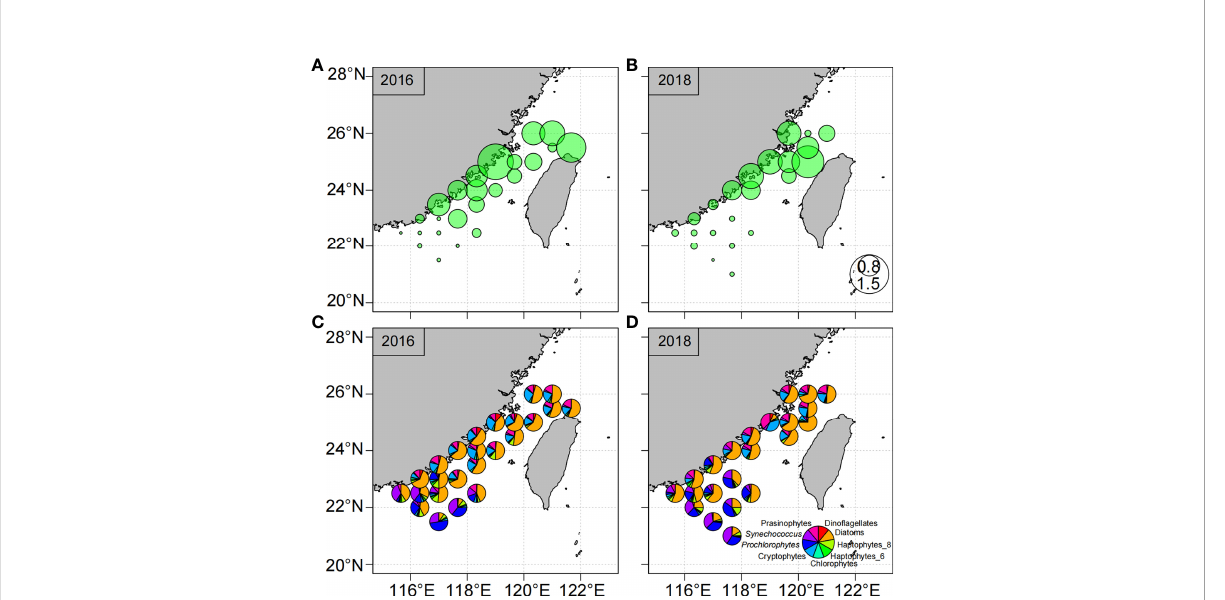
FIGURE 6 Surface total chlorophyll a concentrations (upper, m g L − 1 ) and phytoplankton community structure (below) based on the HPLC analysis during the observations in 2016 (A, C) and 2018 (B, D) . All data are averaged over 0.5°×0.5° grid